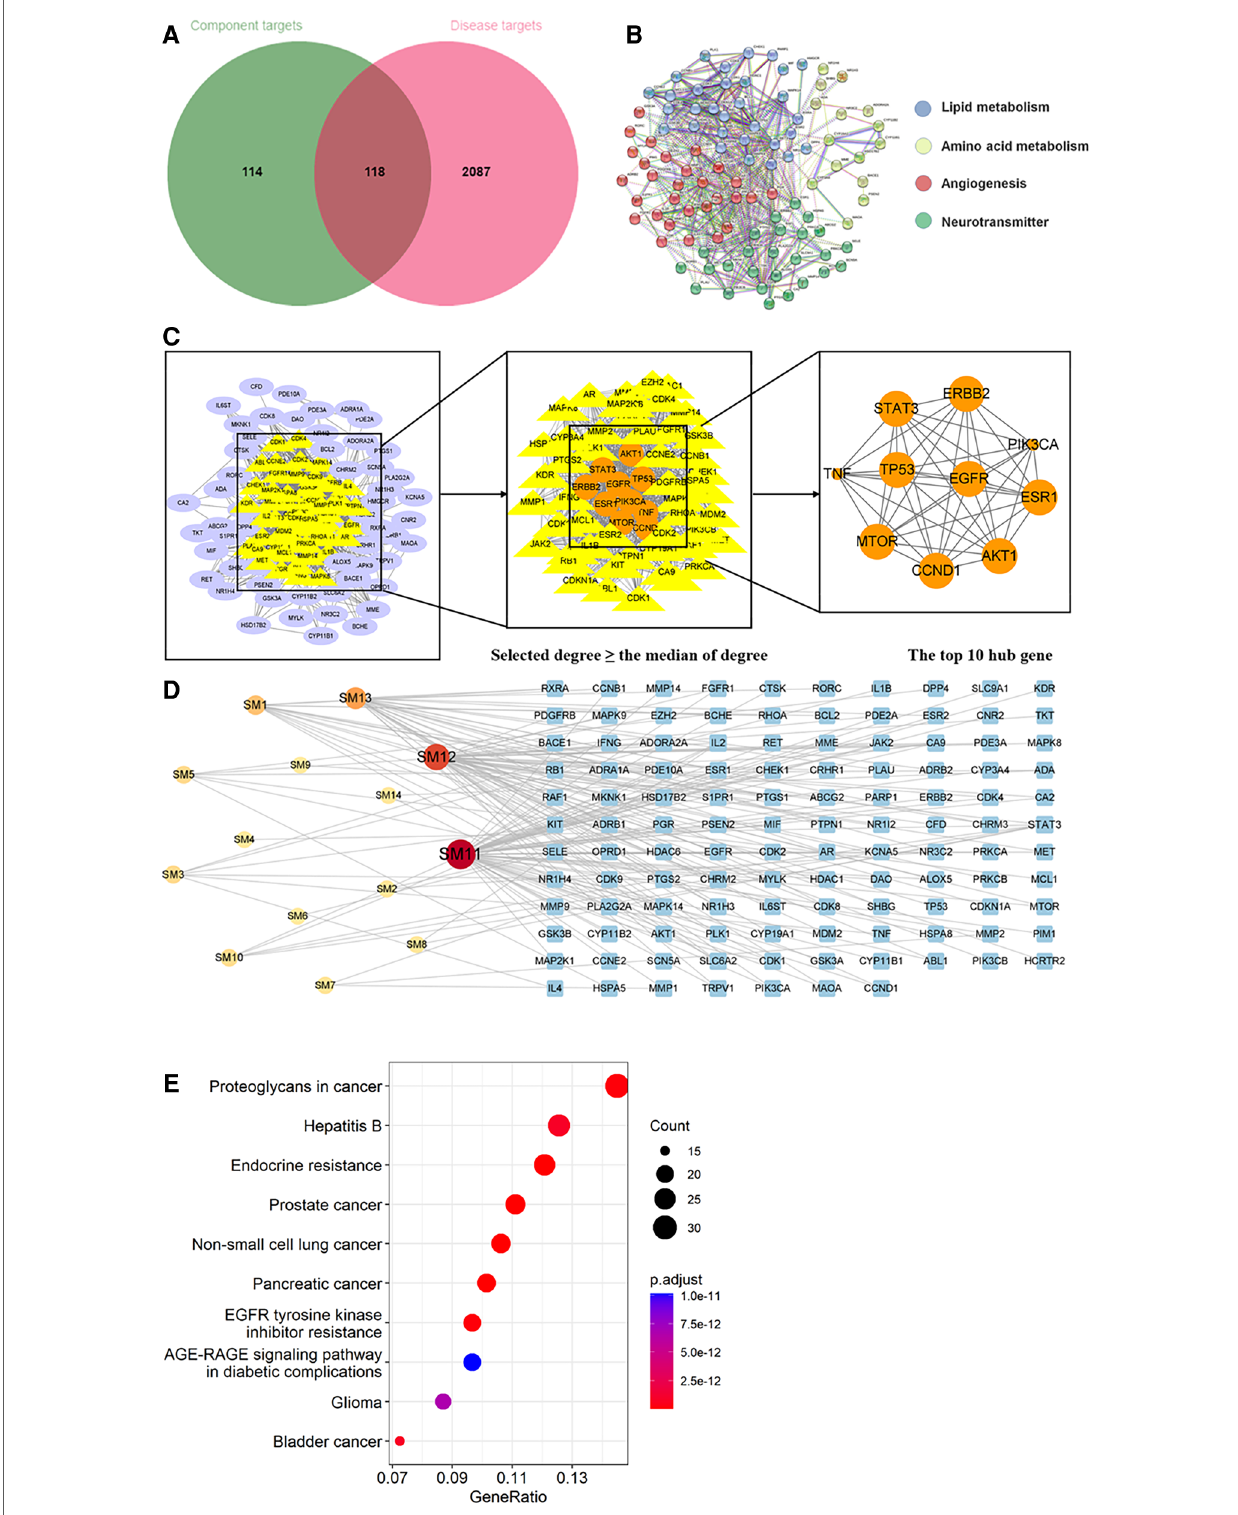
FIGURE 8 Analysis of target genes about shenmai injection. ( A ) Venn diagram of component target genes and disease target genes. The green circle stands for effective component target genes. The red circle stands for AIC target genes, and the intersection genes are shown in the middle. ( B ) The PPI network of the intersection genes. ( C ) Network topology analysis to screen the hub targets. ( D ) Component-Target Network of the active components and the target genes. ( E ) KEGG enrichment analysis of hub